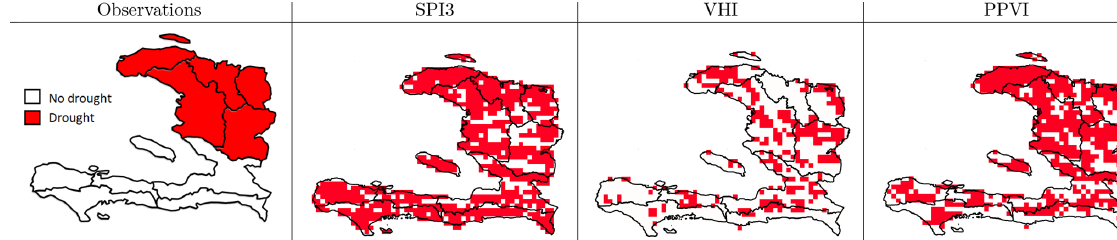
Figure 10. Same as Fig. 8 but for week 8 of 2012. Departments highlighted in red are the ones in drought according to observations; red cells are the ones in drought conditions according to the various indices. Table 11. Performance of the PPVI, SPI3 and VHI in identifying departments hit by drought during week 8 of 2012 and comparison with observations. Observations are retrieved from the text-based documents reported in Table